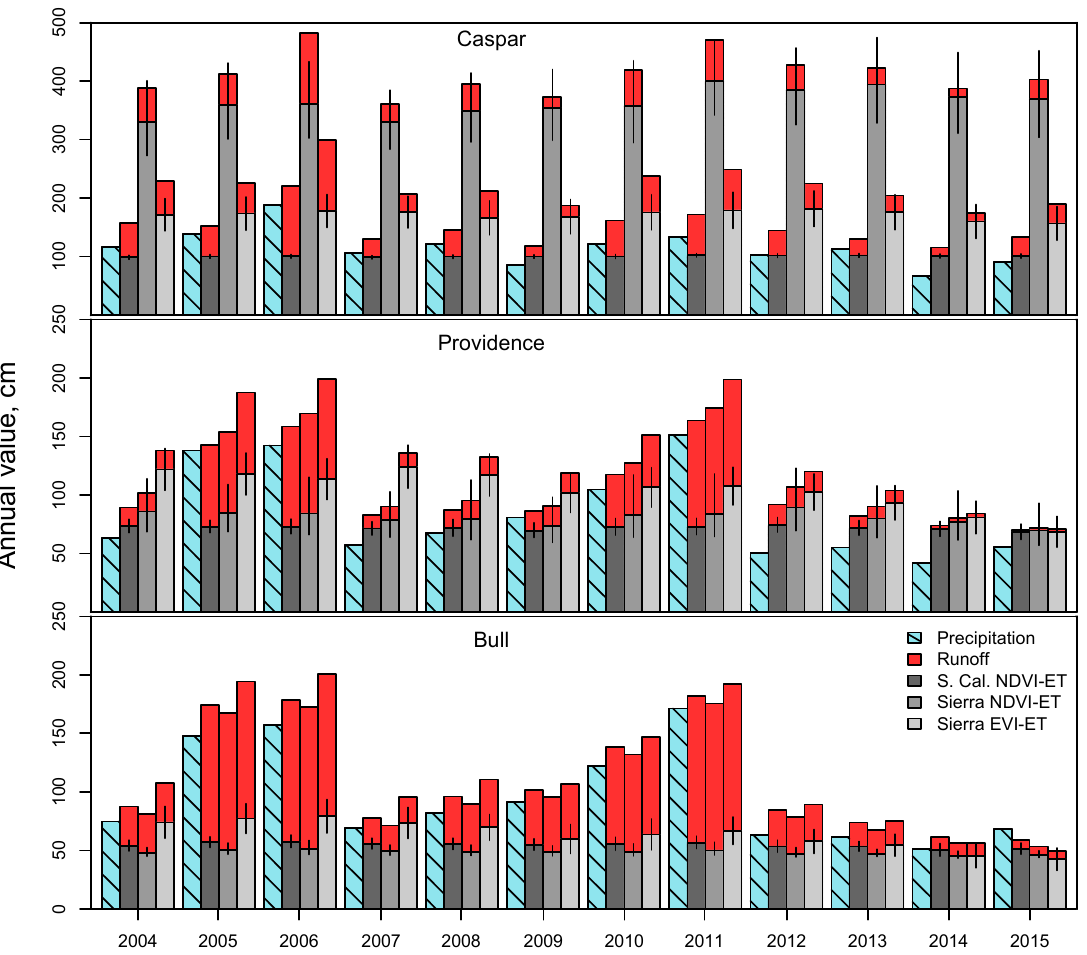
Figure 5. Estimates of water balance closure by comparing annual precipitation with the sum of runoff and evapotranspiration. Water balance values are area-normalized over all sub-watersheds at each site. The three evapotranspiration equations are based on NDVI and southern California flux tower ET measurements (S. Cal. NDVI-ET), NDVI and Sierra Nevada flux tower ET (NDVI-ET), and EVI and Sierra Nevada flux tower ET (Sierra EVI-ET). Vertical bars are standard deviations of the individual pixel vegetation index from the watershed annual mean.